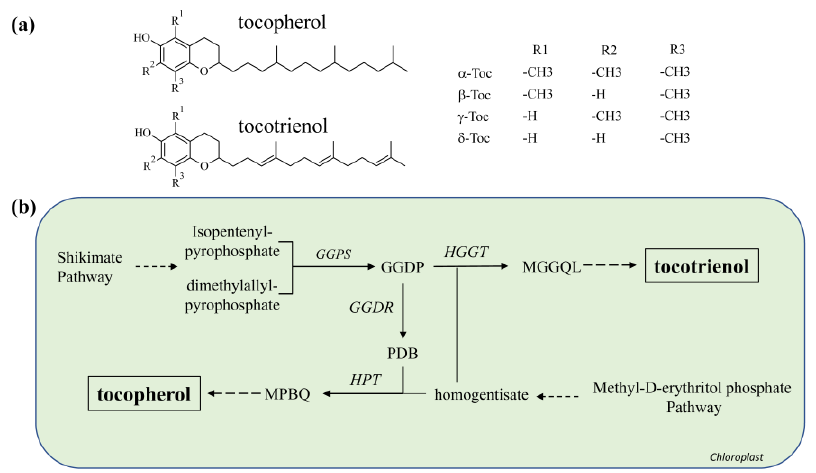
Figure 6. Vitamin E biosynthesis in higher plants. ( a ) Chemical structures of tocopherol and to- cotrienol. ( b ) Key pathways for the biosynthesis of the vitamin include the shikimate and the methyl-D-erythritol phosphate (MEP) pathway. GGDP, geranylgeranyl diphosphate; GGDR, geranyl- geranyl diphosphate reductase; GGPS, geranylgeranyl diphosphate synthase; HGGT, homogentisate geranylgeranyl transferase; HPT, homogentisate phytyl transferase; MPBQ, methylphytylbenzo- quinol; MGGQL,